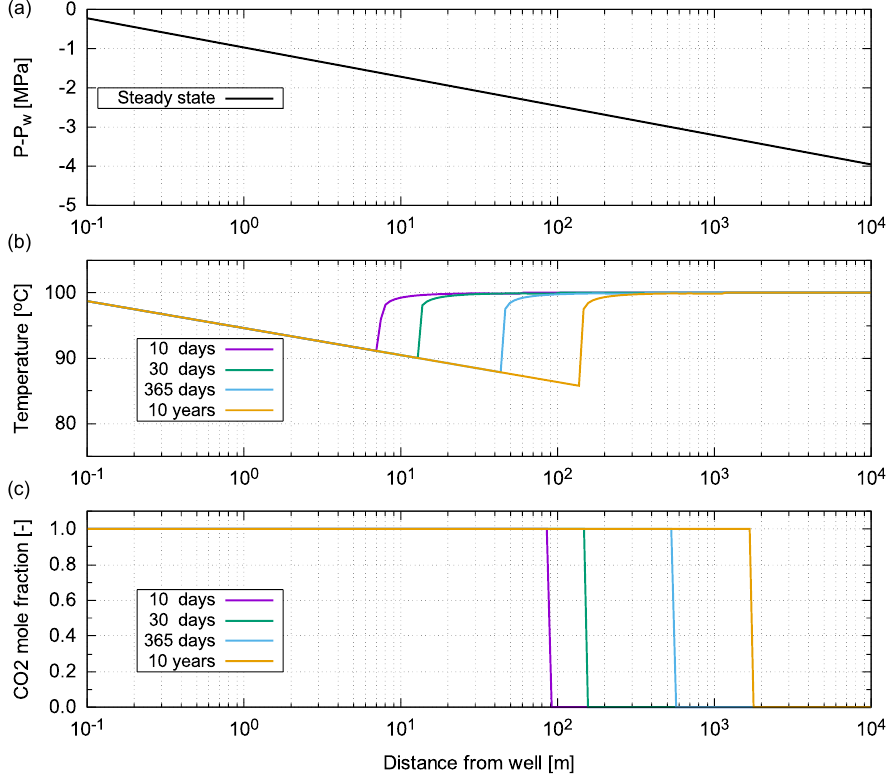
Figure A5. Results of the JTC effect for the depleted gas reservoir considered in the main text. ( a ) Differential pressure from the well pressure, P − P W , as determined by the analytical solution of Darcy’s equation for steady-state radial flow; ( b ) Temperature profile as a function of the distance from the injector; ( c ) CO 2 mass fraction in the gas phase as a function of the distance from the